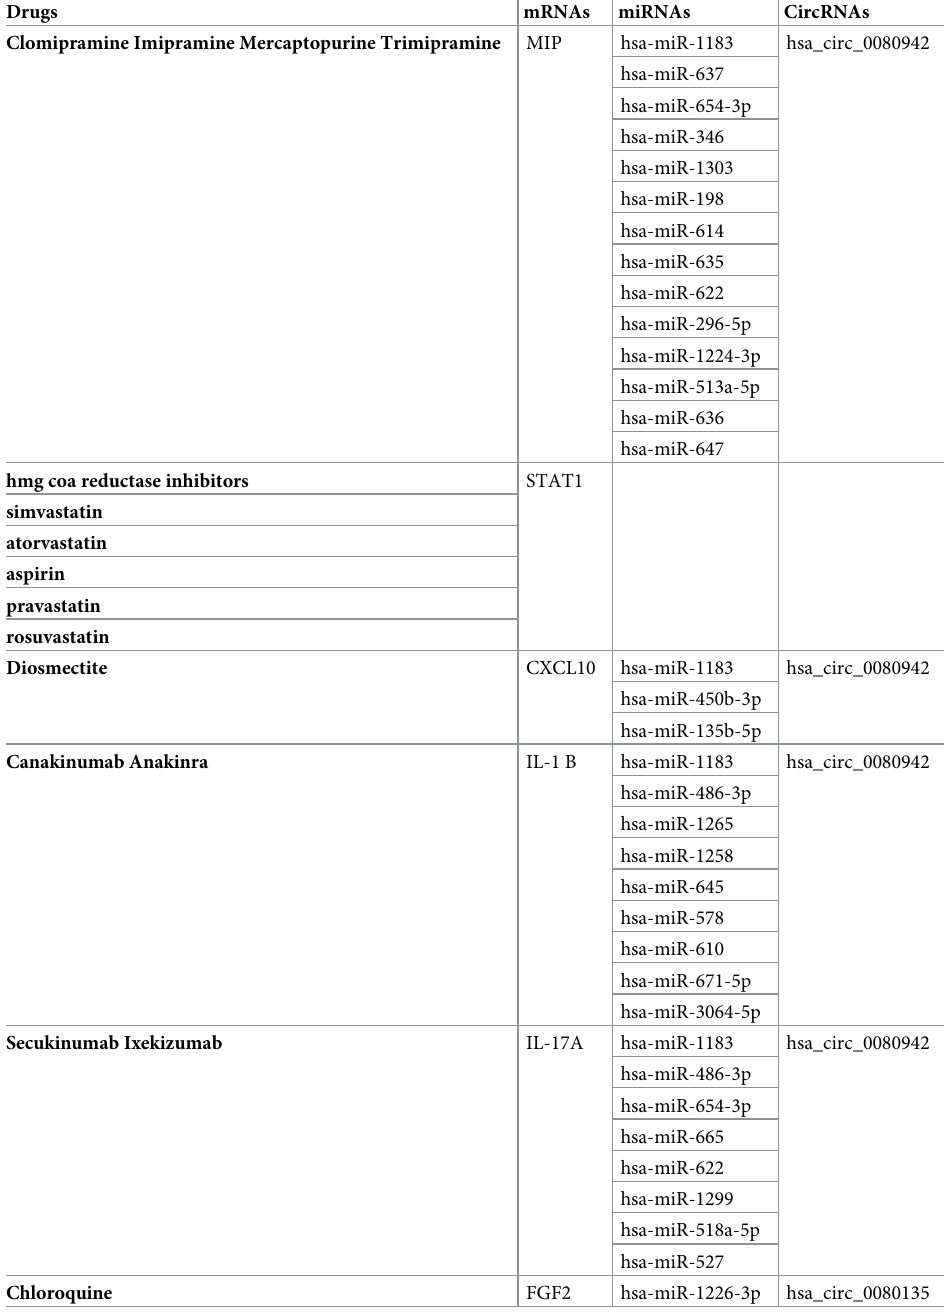
Table 7. Drug targets and their association with prioritized circRNAs during SARS-CoV-2 infection.